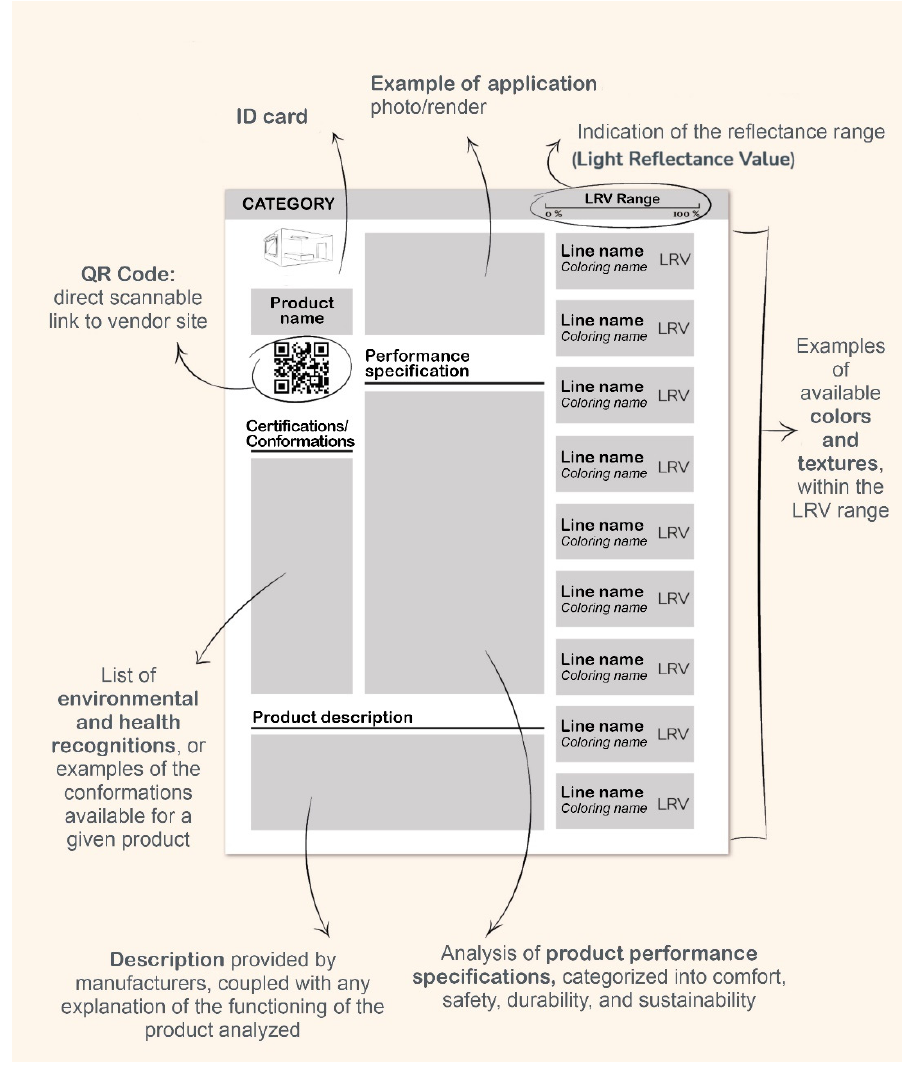
Figure 5. Example of a sheet from the technical solutions collection.